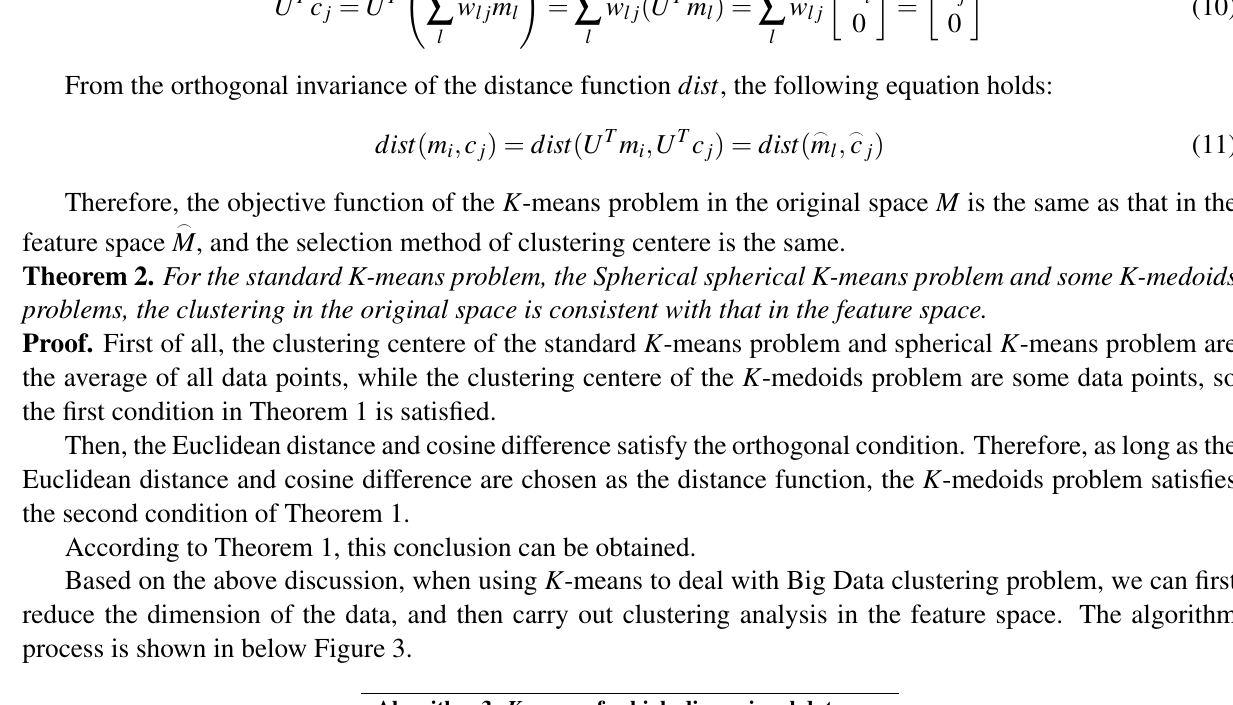
Algorithm 3: K -means for high-dimensional data